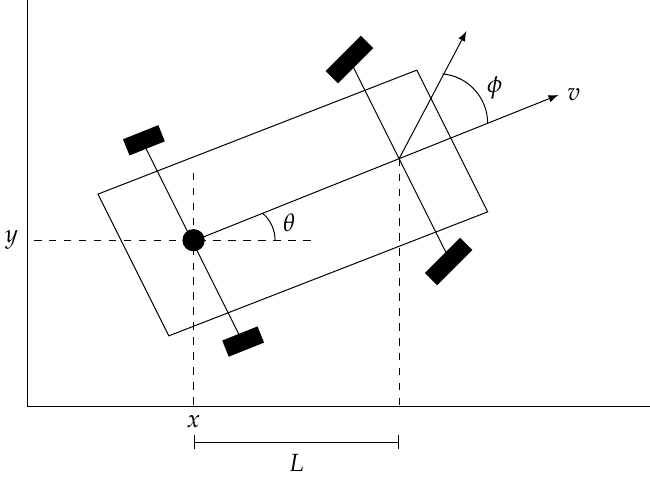
Figure 1. Car-like robot